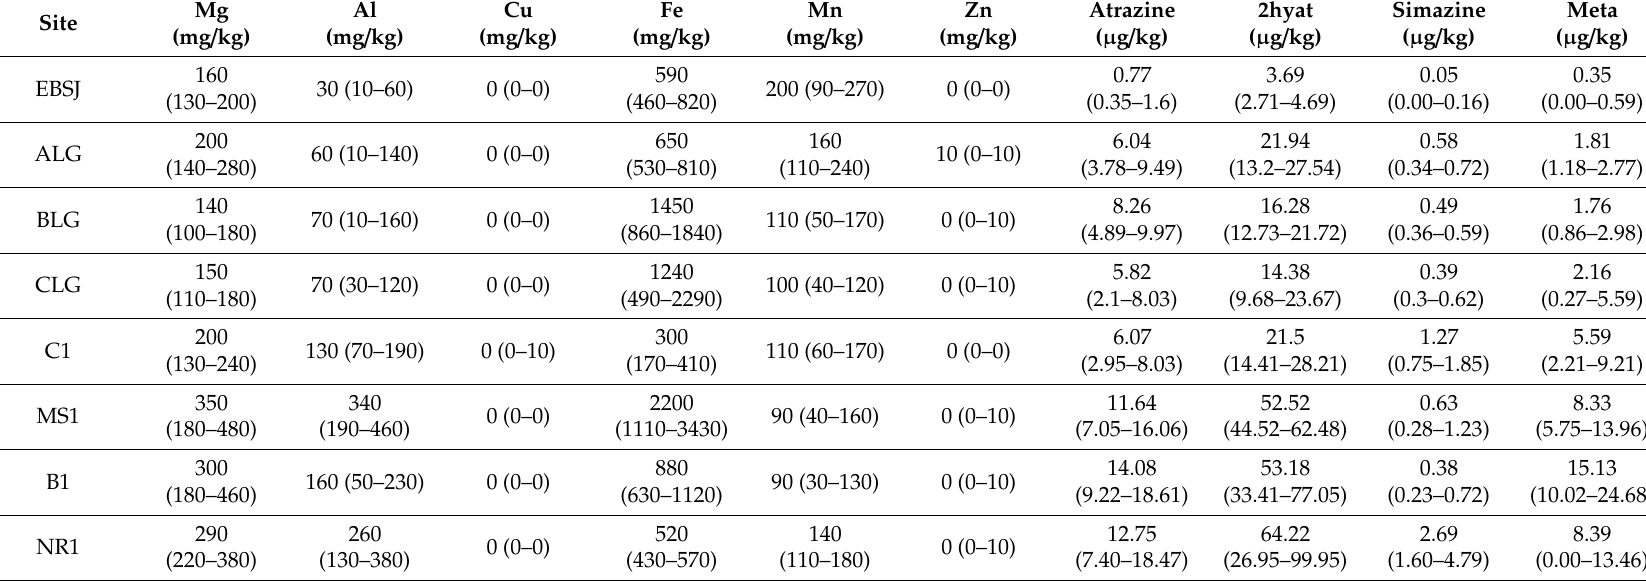
Table 4. Mean values and minimum–maximum values (in parentheses) of one nutrient, five trace metals, three herbicides, and one herbicide metabolite from eight agricultural headwater streams in Indiana, Michigan, and Ohio, 2017 to 2018. Abbreviations are 2hyat-2-hydroxyatrazine and Meta